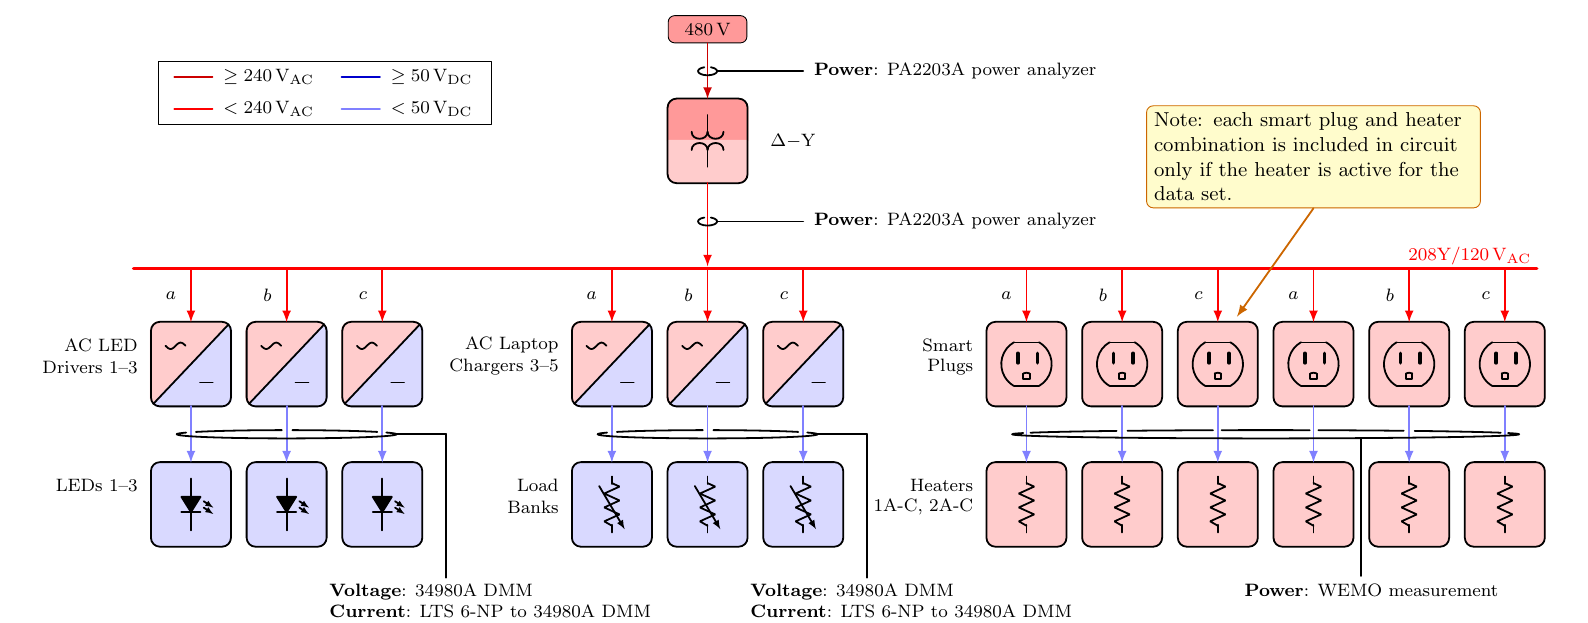
Figure A3. Electrical diagrams for Scenarios 3.3, 3.4, 4.2–4, 5.1, and